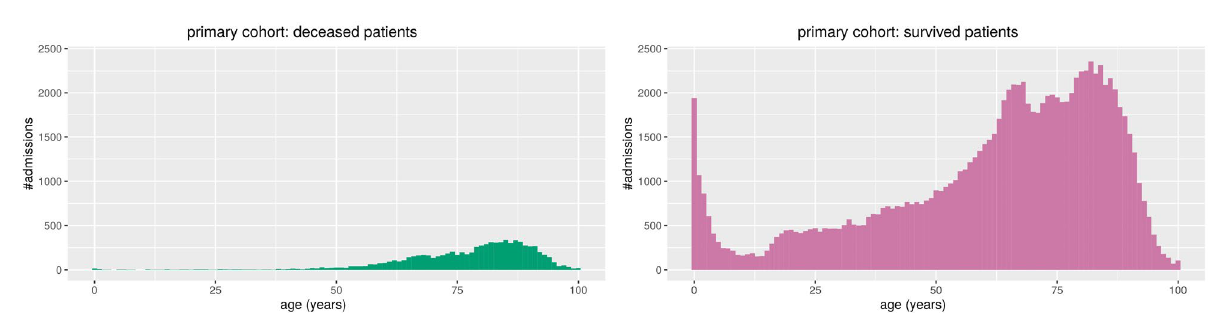
Figure 1. Primary cohort: stacked barplots of the distribution of categories. Distribution of sepsis episode number and sex of the admissions of patients who deceased (left) and survived (right). Admissions of survived patients: positives data instances (class 1). Admissions of deceased patients: negative data instances (class 0).